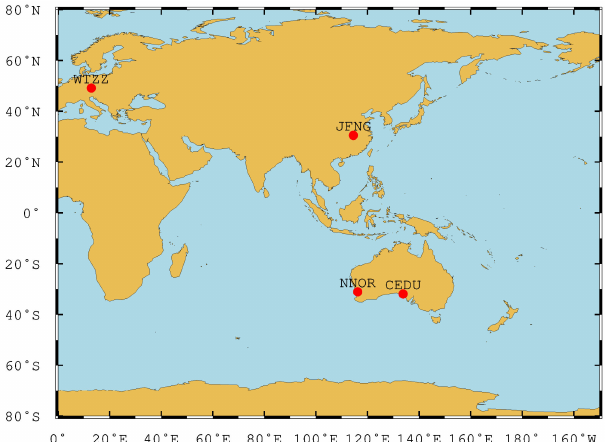
Figure 4. Distribution of selected four multi-GNSS experiment (MGEX) stations.